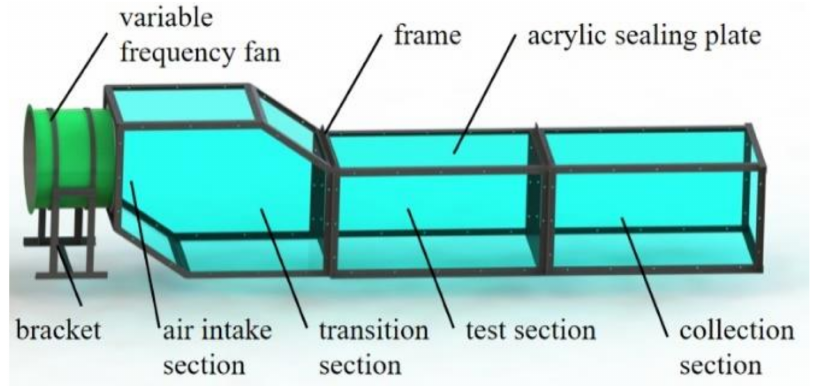
Figure 6. Structural diagram of wind tunnel.